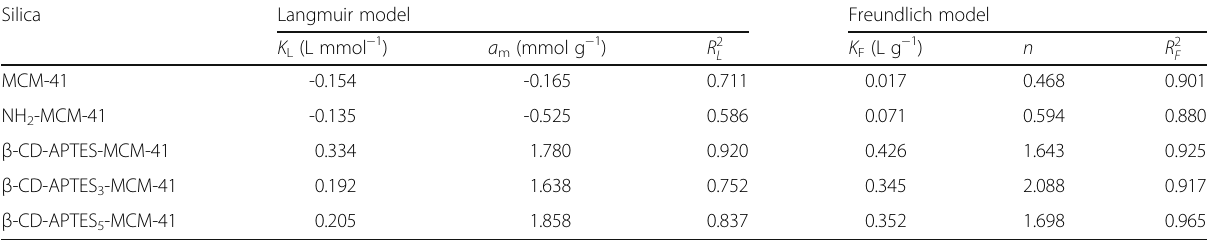
Table 3 Parameters of Langmuir and Freundlich isotherm models for benzene adsorption on MCM-41 silicas Silica Langmuir